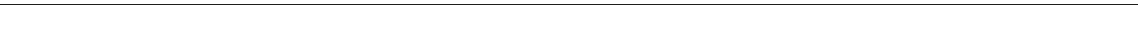
Fig. 7 Ad-TD-nsIL-12 ef fi cacy is dependent on hamster CD3+/CD4 − immune cell subsets. a , b Syrian hamsters were inoculated subcutaneously with 2 × 10 6 HPD1NR cells. The established tumors were injected i.t. with 1 × 10 9 PFU Ad-TD-nsIL-12 or PBS ( n = 7/group) on day 0, 2, 4, 6, 8, and 10. Control IgG and either mouse anti-hamster CD3 mAb (4F11) a or CD4 mAb b were injected i.p. at doses of 500 μ g/injection every fourth day from the day before the viral therapy to the end of the experiment and FACS analysis used to con fi rm the depletion. Mean tumor volumes and SEM are shown for each group. Statistical analysis was carried out using a one-way ANOVA with post hoc Tukey ’ s Multiple Comparison Test. * p < 0.05, *** p < 0.001. c – g 2 × 10 6 HPD1NR cells were seeded into the right fl ank of Syrian hamsters. When tumor volumes reached 300 mm 3 , nine hamsters per group were each injected i.t with PBS, immunohistochemical staining for CD3 and CD4 at day 7 (×200). d − f Quantitative scores of lymphocyte in fi ltration within tumors. Lymphocytes were counted in 5 HPFs randomly selected from each tumor section (×200). The scoring was conducted within the tumor and stroma; necrotic areas were avoided. The extent of lymphocyte in fi ltration was categorized into the following four grades: 1, < 25 cells/HPF; 2, 25 – 49 cells/HPF; 3, 50 – 75 cells/HPF; 4, > 75 cells/HPF. Statistical analysis was carried out using a one-way ANOVA with post hoc Tukey ’ s Multiple Comparison Test. * p < 0.05, ** p < 0.01, *** p < 0.001. g Spleens and lymph nodes were collected and analyzed by FACS for CD3 and CD4 expression at the time points shown. Mean expression and SEM is plotted ( n = 3/group). Statistical analysis was carried out using a one-way ANOVA with post hoc Tukey ’ s Multiple Comparison Test. * p < 0.05, ** p < 0.01, *** p <